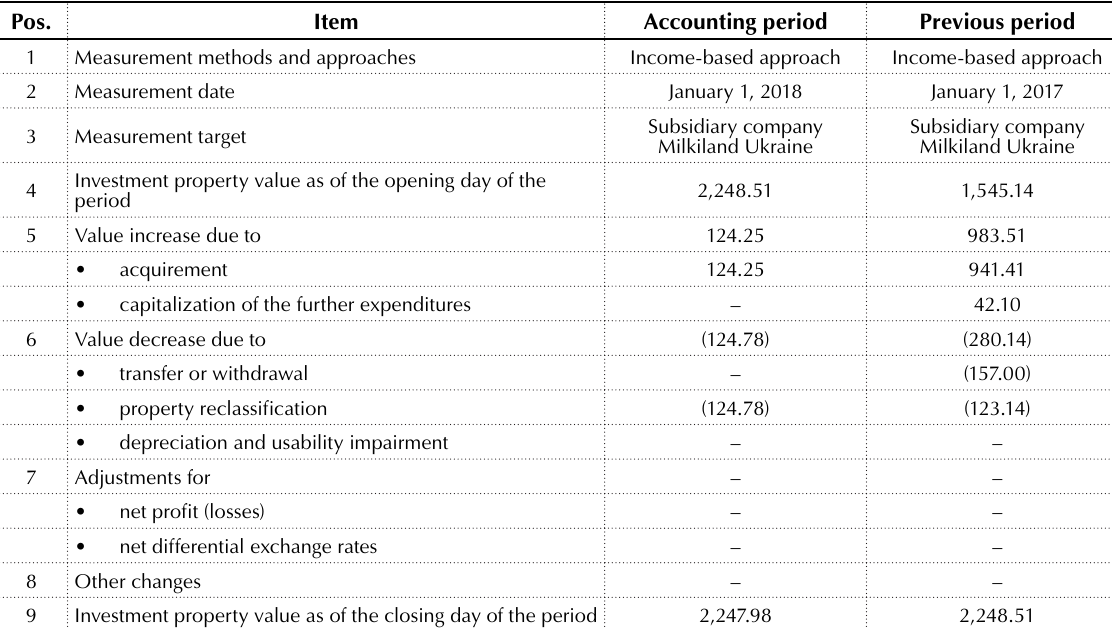
Source: Developed by the